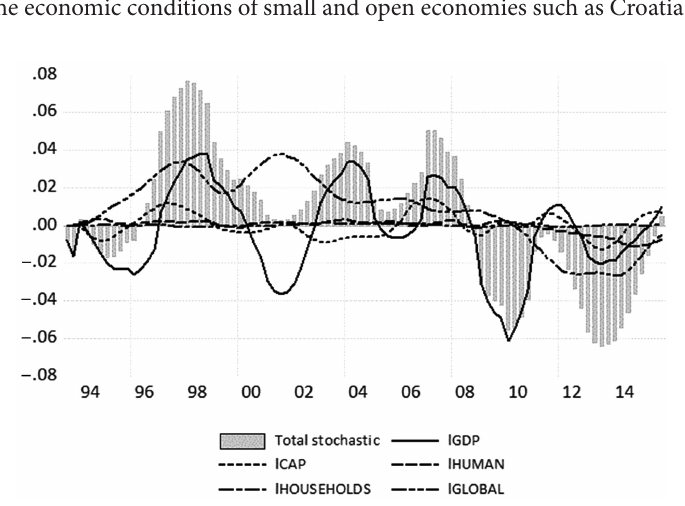
Figure 6. Variance decomposition of lGDP (with lFIRMS) (source: authors’ calculation)